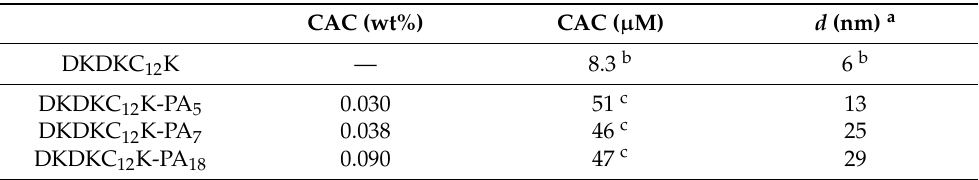
Table 2. CAC and hydrodynamic diameter ( d , nm) of DKDKC 12 K-PA n in 100 mM phosphate buffer (pH